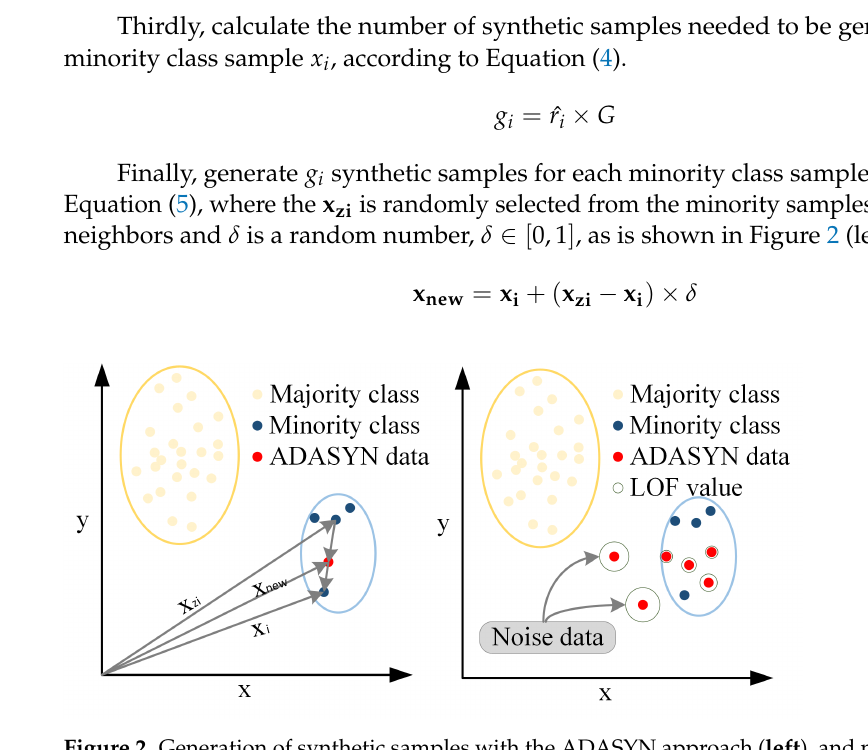
Figure 2. Generation of synthetic samples with the ADASYN approach ( left ), and noise identification with the LOF approach ( right ) (the size of the circle outside of the red sample is the LOF